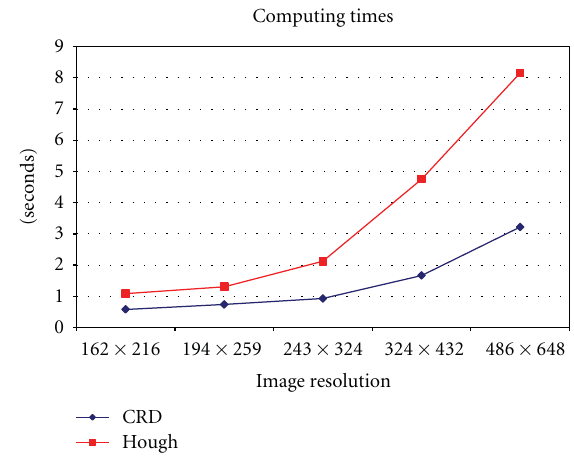
Figure 7: Times in seconds against the di ff erent image